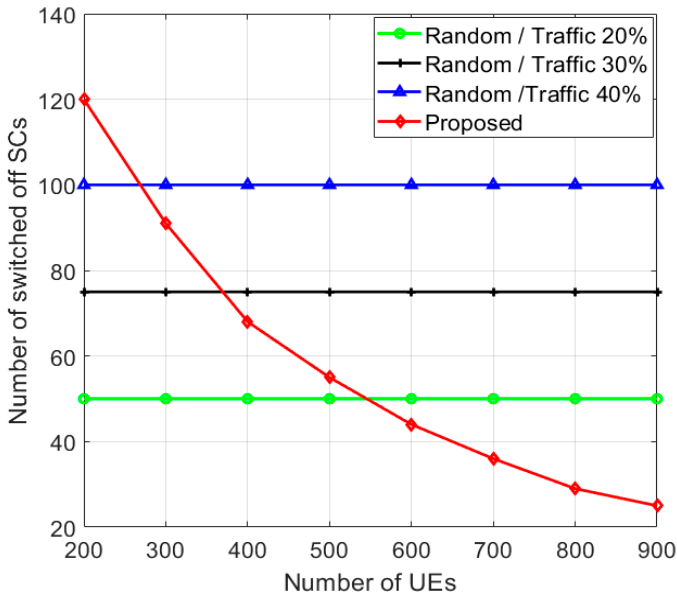
Figure 15. Number of switched off SCs for different numbers of UEs.